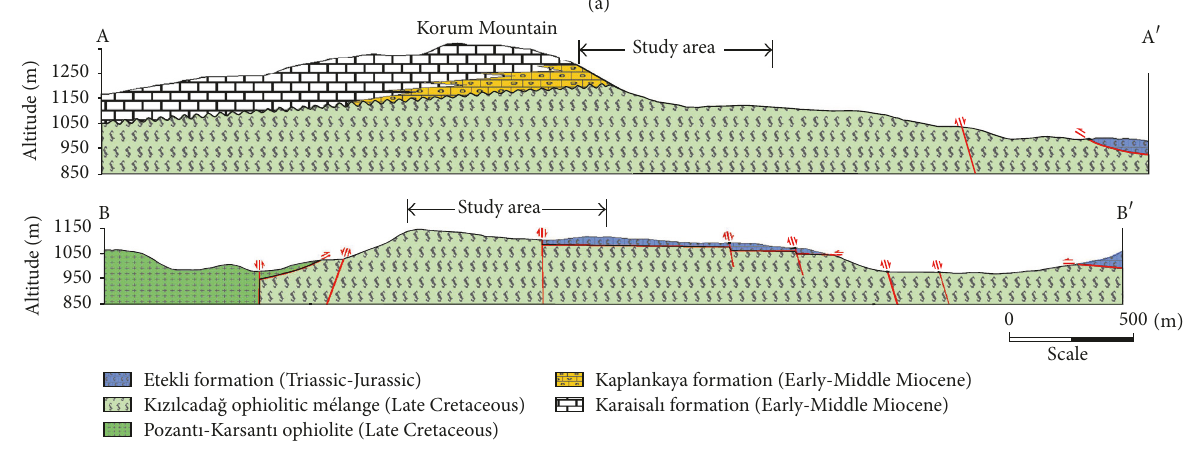
Figure 3: (a) Detailed geological map (adapted from [36]) of the region surrounding the Kızılgedik site (shown in the red box) overlaid on a digital elevation model (DEM) with a grid size of 10m and (b) generalized geological cross sections along the lines A–A 󸀠 (SW to NE) and B–B 󸀠 (NW to SE) in (a) showing the subsurface lithology and major tectonic structures (faults shown in red